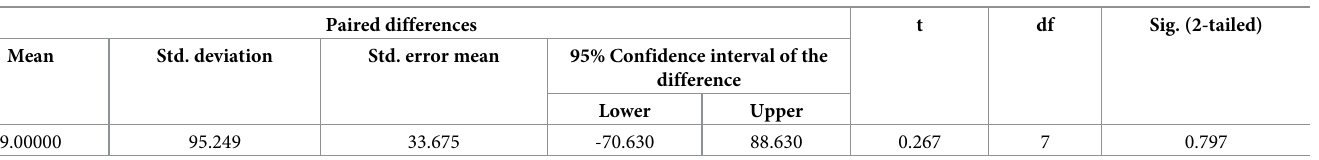
Table 7. Paired samples significance